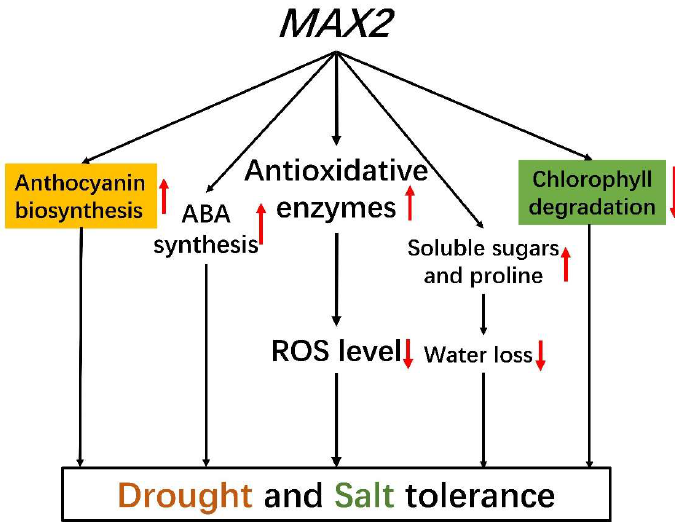
Figure 10. Model of SsMAX2 in the regulation of drought and salt adaptation. The arrows indicate the downregulated or upregulated activities.